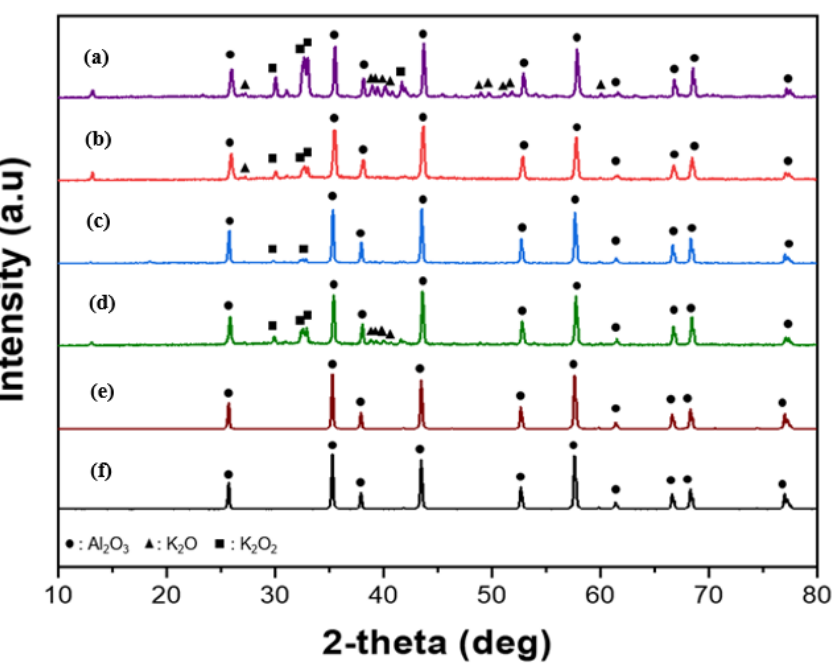
Figure 2. XRD patterns for ( a ) powder Al 2 O 3 , ( b ) beads Al 2 O 3 , ( c ) powder KOH/Al 2 O 3 , ( d ) beads KOH/Al 2 O 3 , ( e ) powder K 2 CO 3 /Al 2 O 3 , and ( f ) beads K 2 CO 3 /Al 2 O 3 .